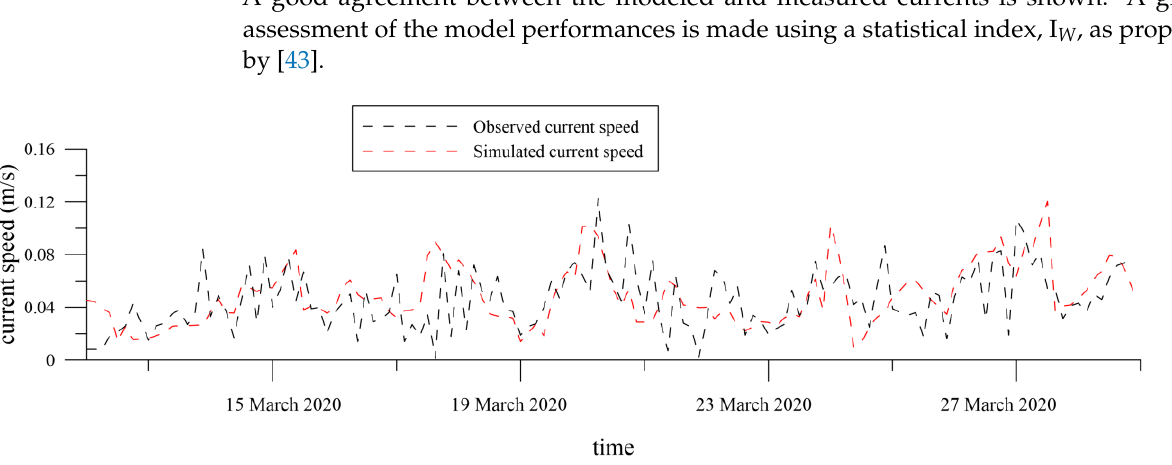
Figure 6. Comparison between the time series of the measured (in the MG station) and the modeled current velocities (MIKE 3 FM HD) at z = −5 m. current velocities (MIKE 3 FM HD) at z = − 5